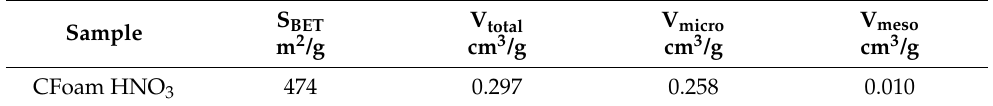
Table 2. Textural properties of activated carbon foam.